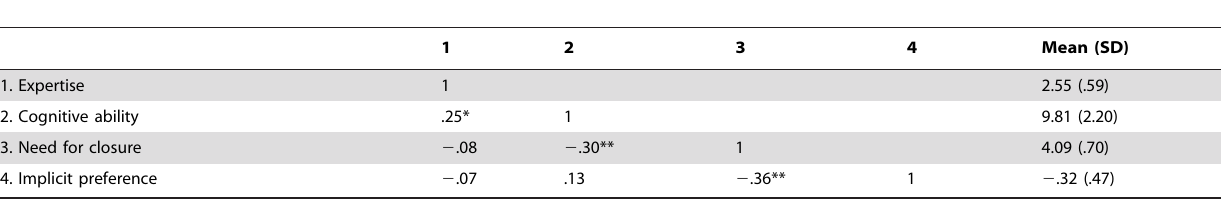
Table 2. Study one: Means, standard deviations and correlations among variables.